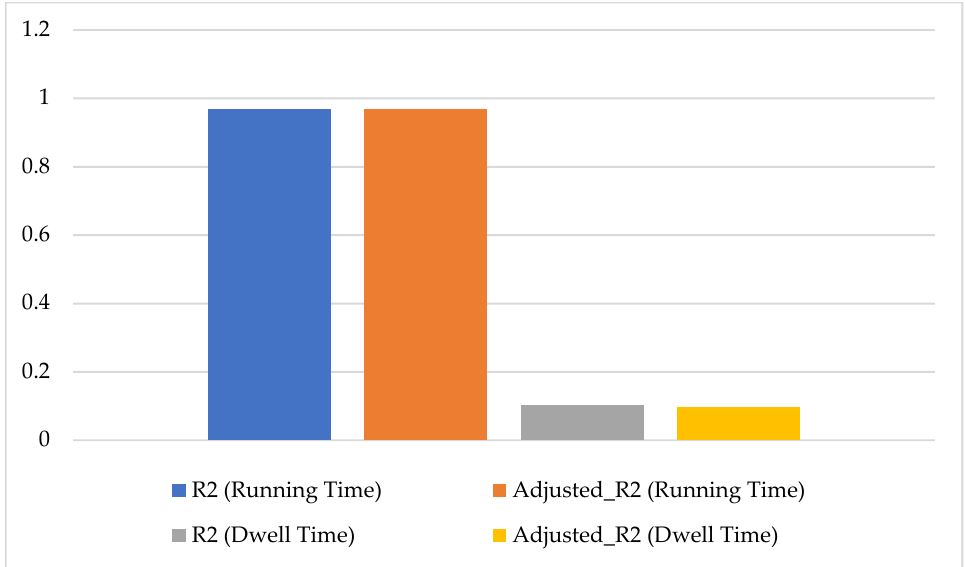
Figure 7. R-squared and Adjusted R-squared.